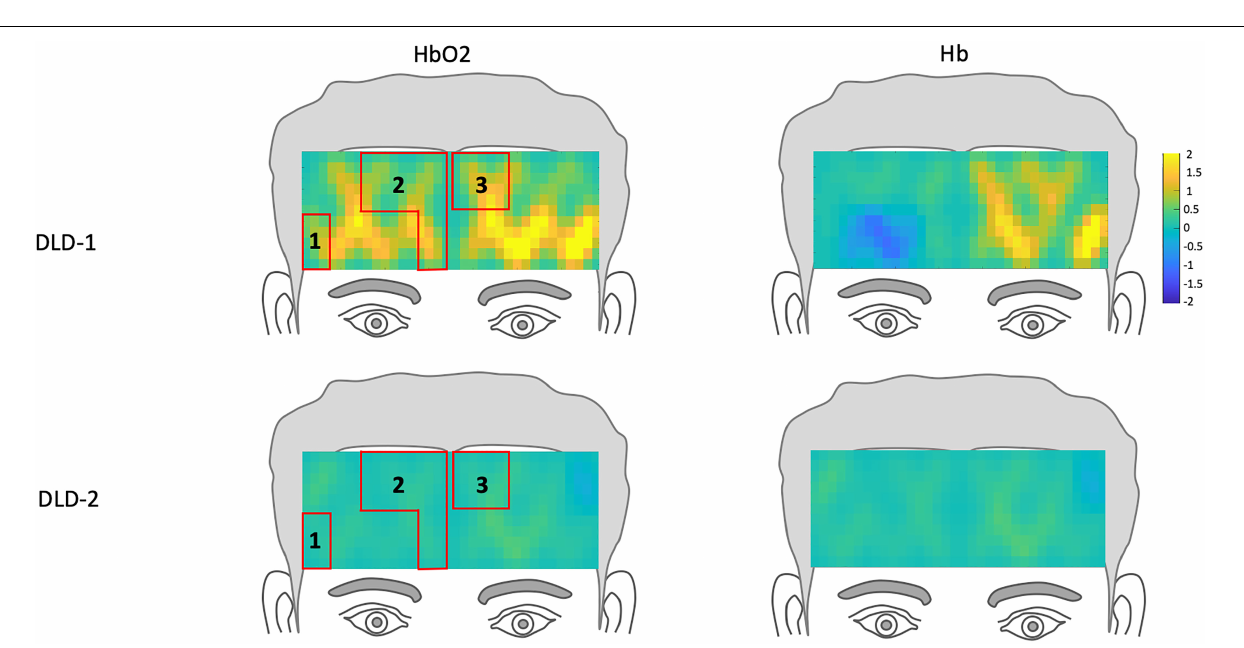
FIGURE 3 | Hemodynamic topography of activation in the prefrontal cortex for normal controls, including ROIs outlined in red. HbO 2 and Hb for high-frequency condition with ROIs 1-3, and HbO 2 and Hb for low-frequency condition, with ROIs 4 and 5.